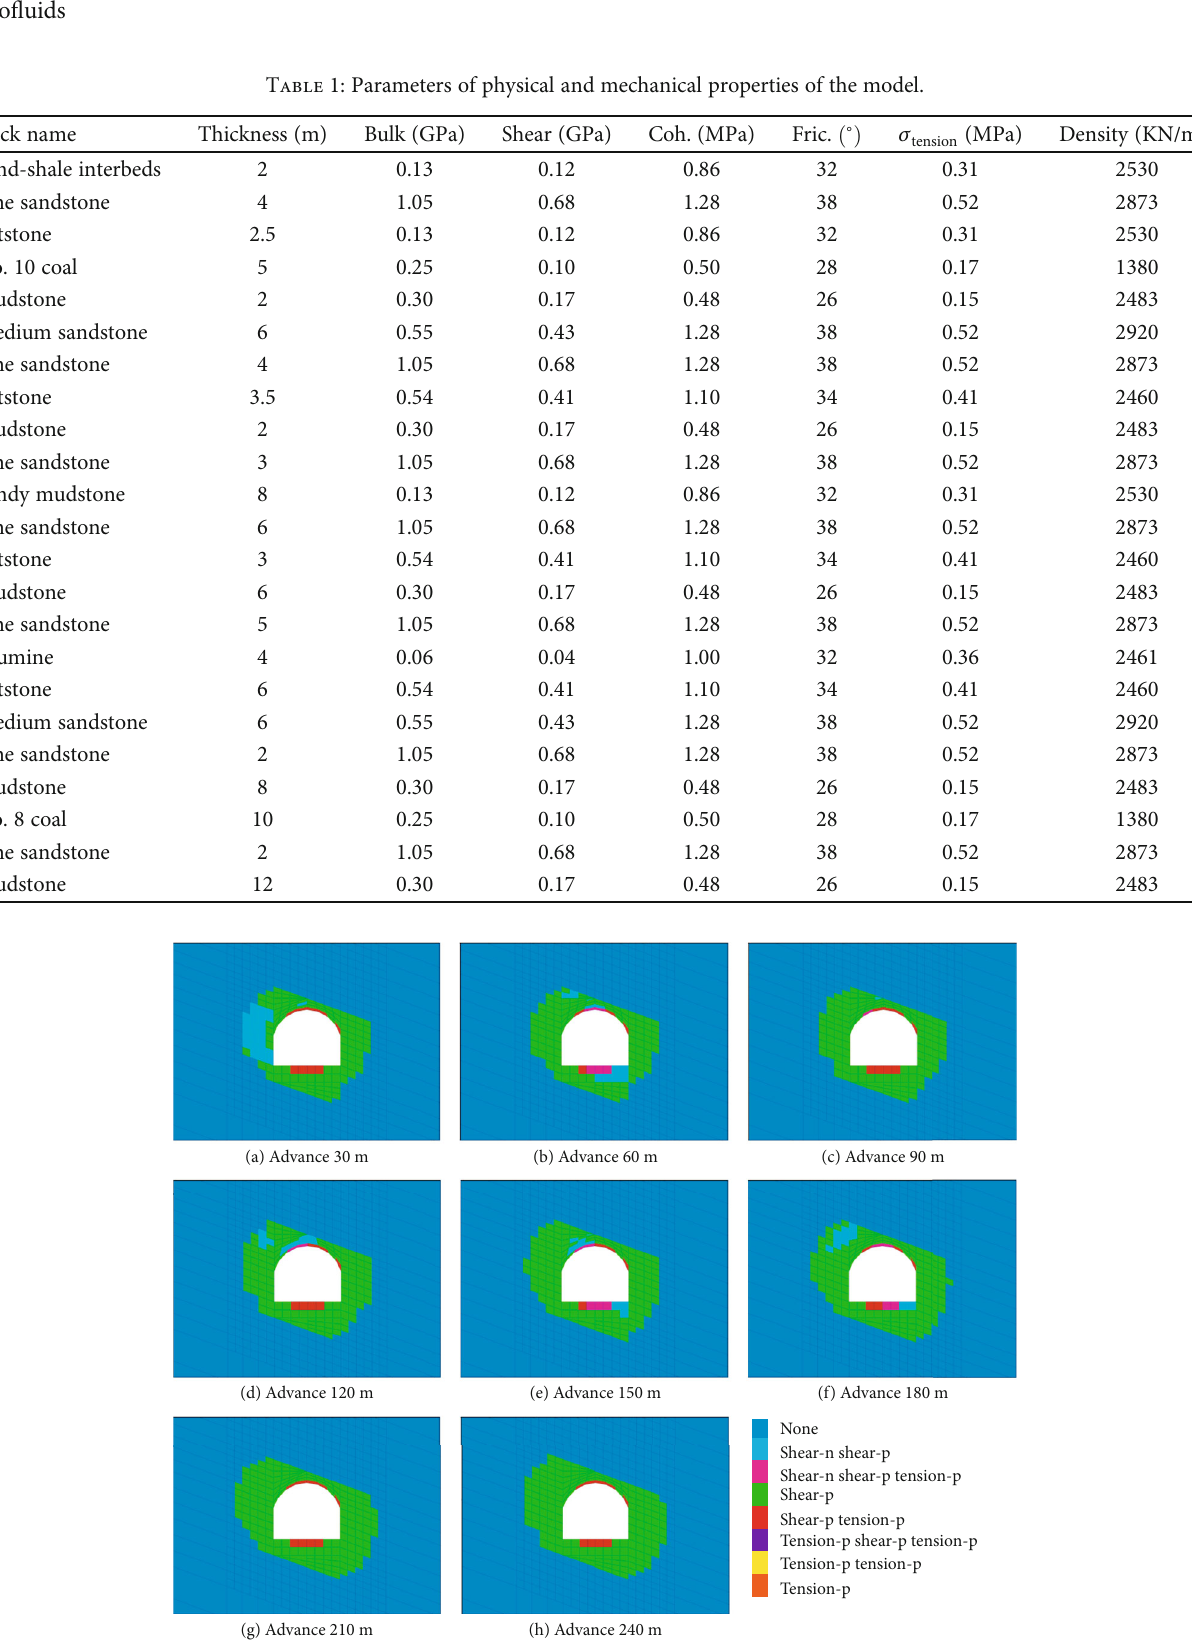
Figure 11: Distribution of characteristics of failure fi eld of the surrounding rock at various positions from the working